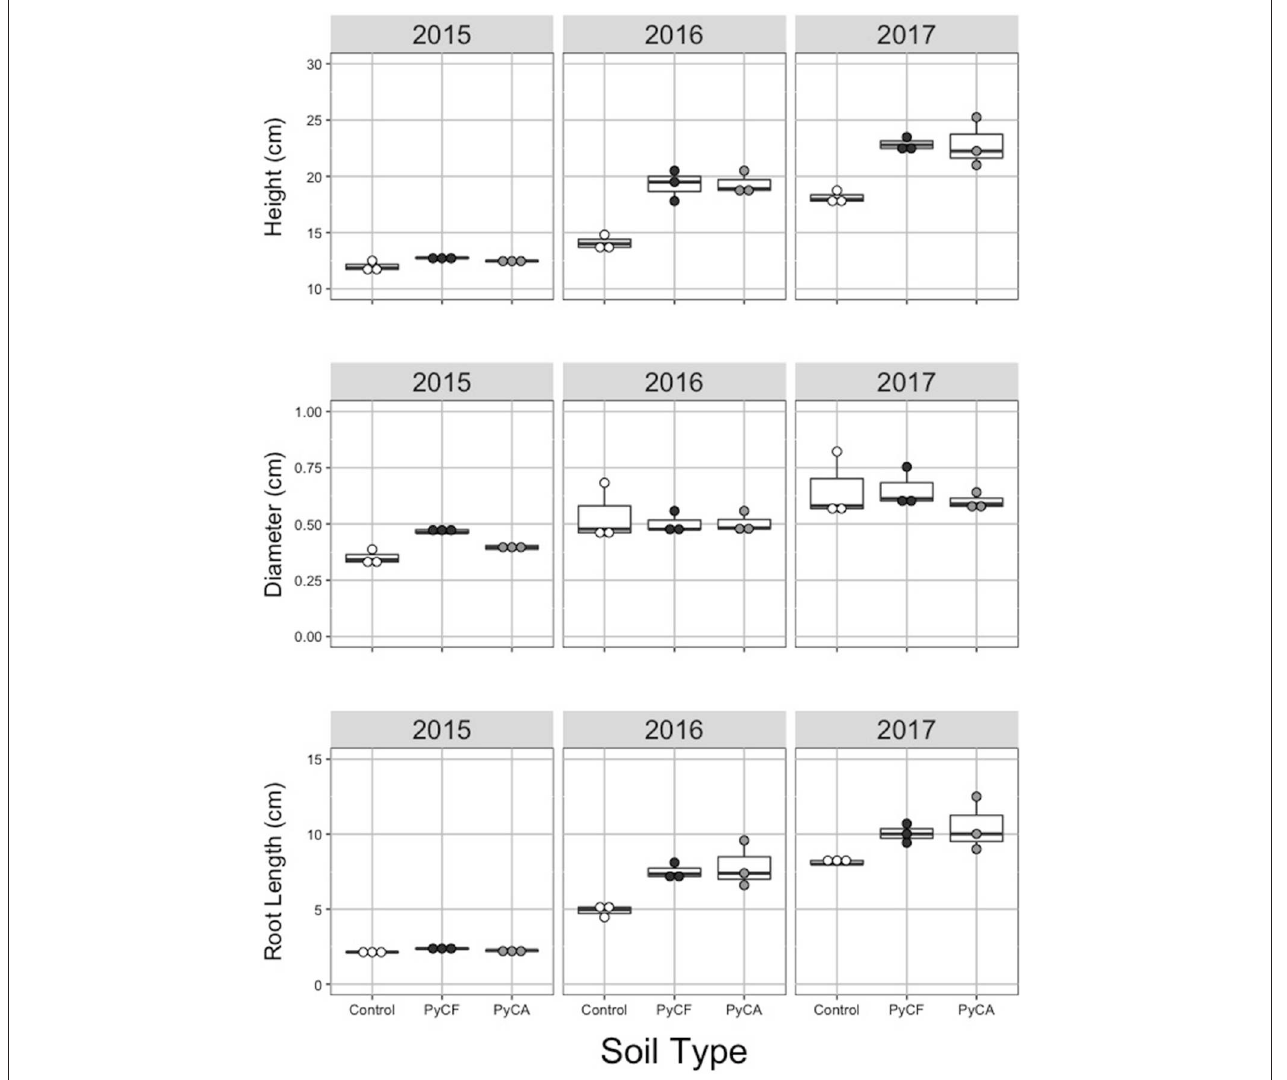
FIGURE 2 | Dot and box plots of plant height (top), diameter (middle), and root length (bottom) for soil-less media controls (white dots) and media amended with forest (PyCF; dark gray dots) and recycled feedstock (PyCA; light gray dots) pyrogenic carbon in 2015, 2016, and 2017. Statistical results can be found in Table 1 .